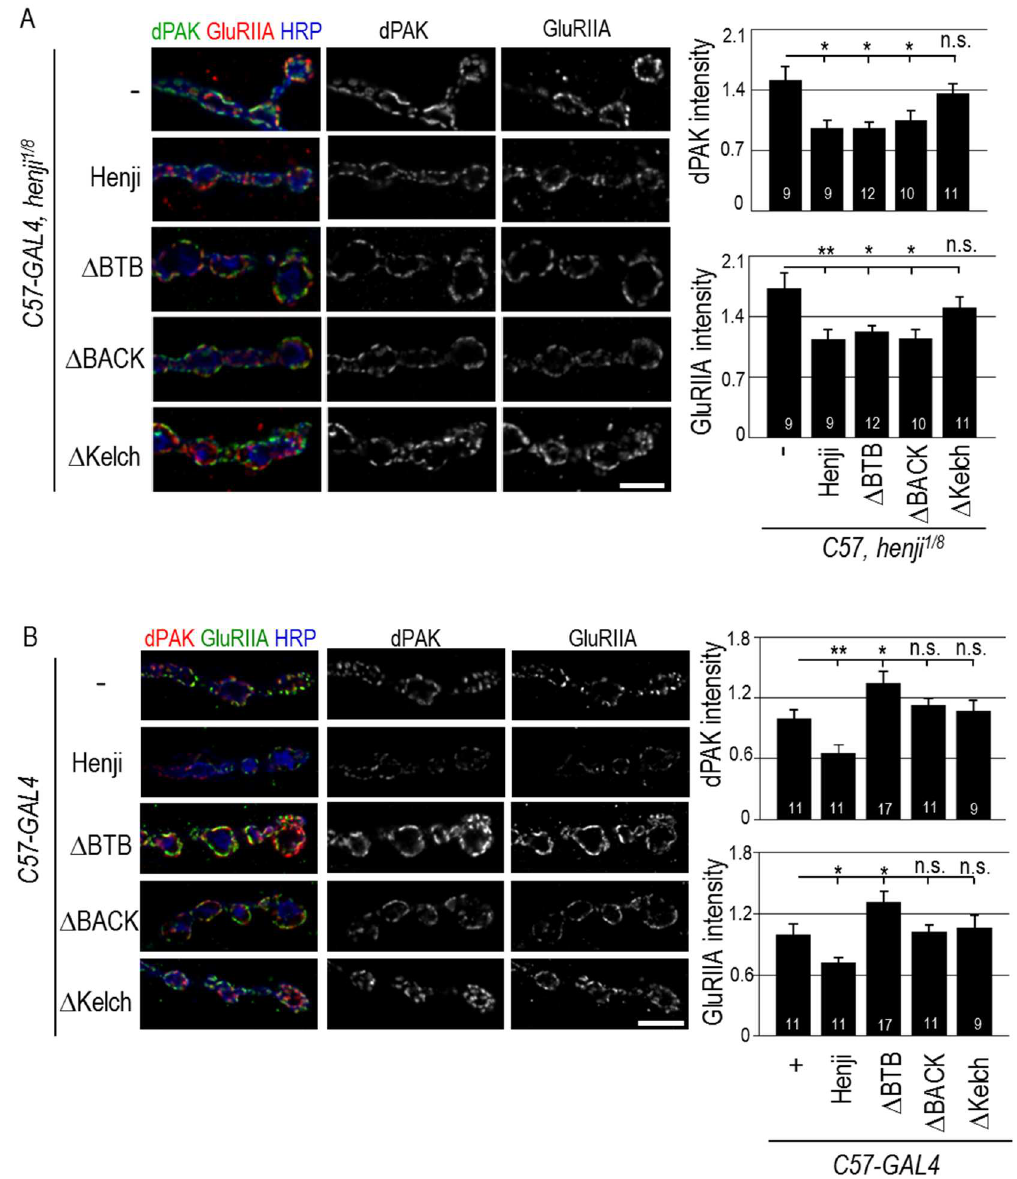
Fig 6. Kelch repeats of Henji suppresses dPAK and GluRIIA elevations in henji mutants. (A) GFP-Henji fusion protein and GFP-fused truncations Δ BTB, Δ BACK, and Δ Kelch were expressed in muscles by C57-GAL4 to test the suppression of elevated dPAK and GluRIIA levels at the henji 1/8 NMJs that were co-stained with HRP. Scale bar is 5 μ m. GluRIIA and dPAK levels were quantifiedand normalizedto HRP. C57-GAL4 henji 1/8 , 1.73 ± 0.18 and 1.52 ± 0.15; C57 > Henji henji 1/8 , 1.14 ± 0.11 and 0.96 ± 0.09; C57 >Δ BTB henji 1/8 , 1.23 ± 0.07 and 0.96 ± 0.07; C57 >Δ BACK henji 1/8 , 1.15 ± 0.11 and 1.06 ± 0.10; and C57 >Δ Kelch henji 1/8 , 1.50 ± 0.13 and 1.36 ± 0.11. (B) Overexpression of full-length Henji, Δ BTB, Δ BACK, and Δ Kelch by C57-GAL4 in muscles to examine their effects on dPAK and GluRIIA postsynaptic levels. dPAK and GluRIIA intensities were quantifiedand normalizedto HRP intensity. C57-GAL4 , 1.00 ± 0.10 and 1.00 ± 0.08; C57 > Henji , 0.72 ± 0.05 and 0.66 ± 0.07; C57 >Δ BTB , 1.31 ± 0.10 and 1.35 ± 0.11; C57 >Δ BACK , 1.03 ± 0.06 and 1.13 ± 0.07; and C57 >Δ Kelch , 1.06 ± 0.13 and 1.08 ± 0.11). Scale bars are 5 μ m in (A, B). Statistical significance was tested by unpairedStudent t-test was comparedto C57-GAL4 henji 1/8 (A) or C57-GAL4 (B) with * for p < 0.05, ** for p < 0.01, *** for p < 0.001, and n.s. for p >